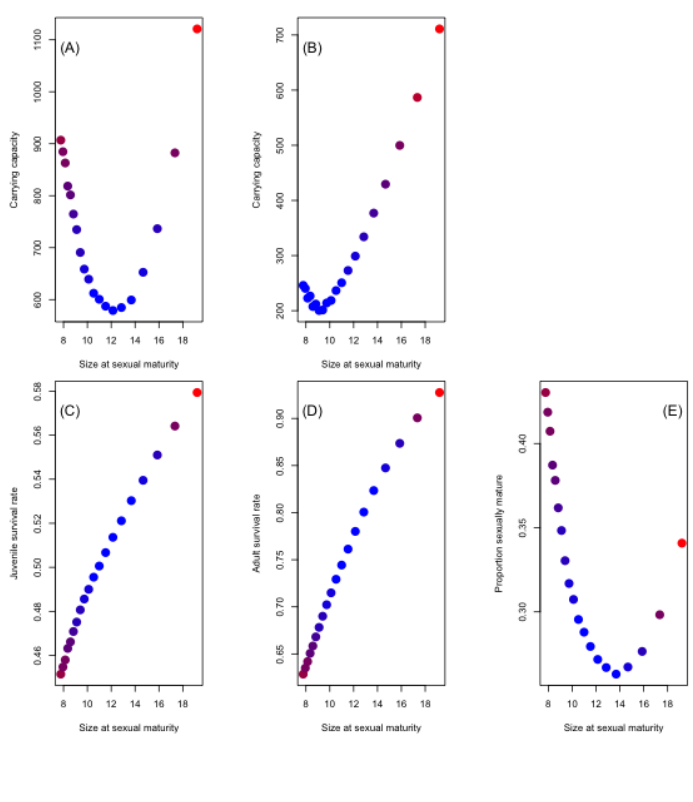
Figure 2. Scenario outcomes and why different life histories have different carrying capacities at equilibrium. Disruptive selection on size at sexual maturity for (A) the density-dependent reproduction scenario and (B) the density-dependent juveniles survival scenario. Each point represents one of our 20 life histories. The redder the colour of a point, the fitter the life history strategy. Association between size at sexual maturity and (C) juvenile survival, (D) adult survival, and (E) proportion of the population that is sexually mature for the density-dependent reproduction